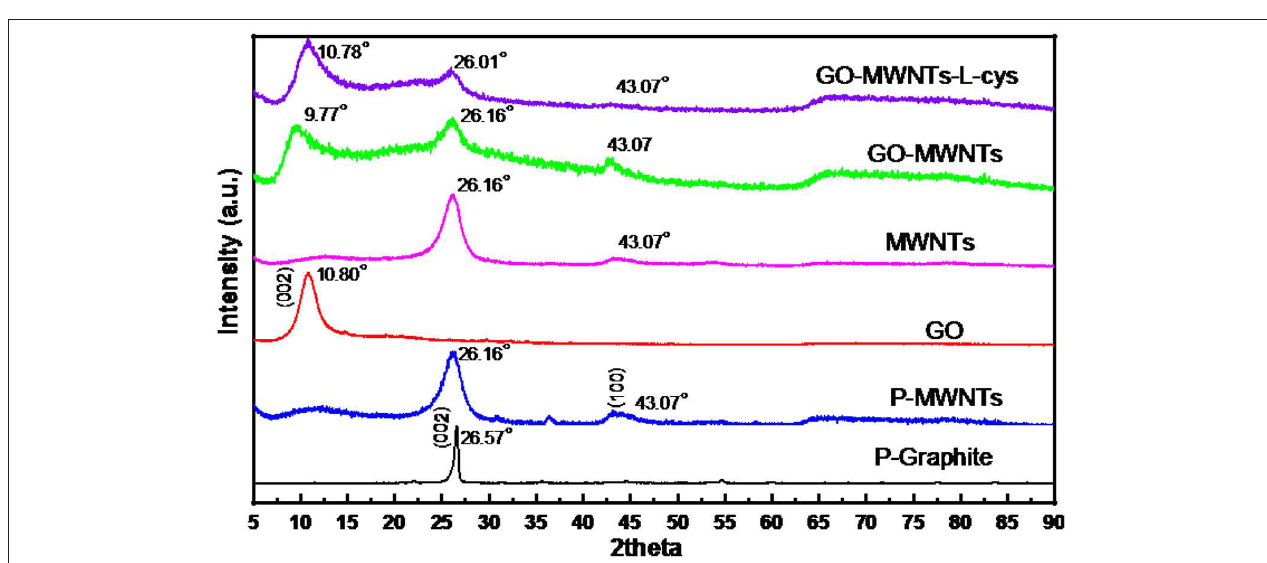
FIGURE 5 | Powder XRD patterns of P-Graphite, P-MWNTs, functionalized MWNTs, GO, GO–MWNTs, and GO–MWNTs–L-cys (from down to up), respectively.